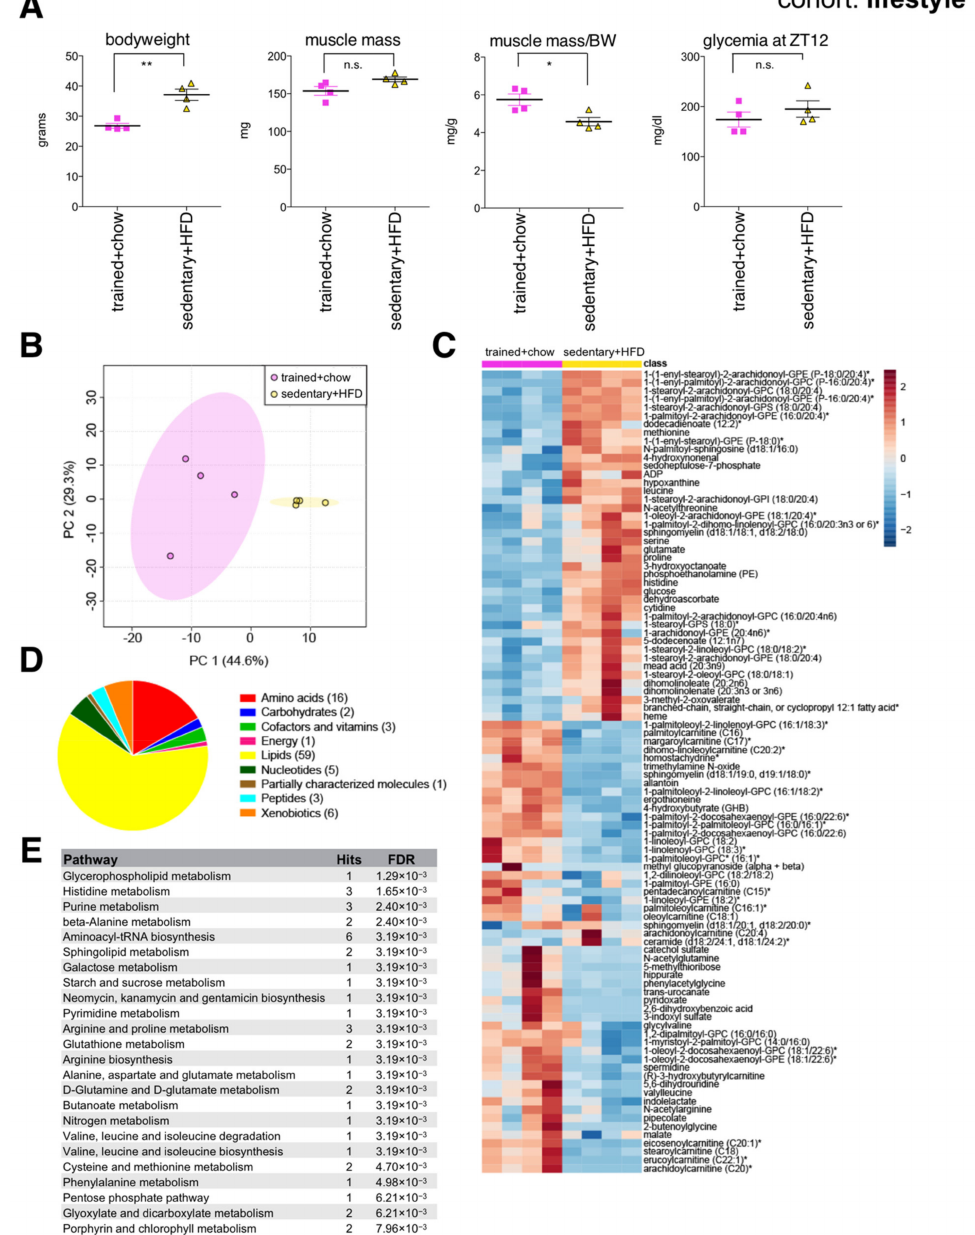
Figure 4. The skeletal muscle metabolome reflects changes associated with lifestyle. ( A ) Bodyweight, muscle weight ( gastrocnemius ), muscle weight relative to bodyweight (BW), and glycemia at zeitgeber time 12 (ZT12, 6 pm) of male C57BL/6J mice after five weeks of daily endurance training (1 h on a motorized treadmill) and eating a chow diet, or sedentary littermates after three months eating a high fat diet (HFD) (mean ± SEM; n = 4; ** p < 0.01, * p < 0.05, n.s. not significant, Student’s t -test). ( B ) Principal component analysis of the entire data set. ( C ) Heatmap of metabolites selected by random forest shown for individual samples. Metabolites labeled with an asterisk have not been confirmed with a standard, but we are confident of their identity. ( D ) Classification of random forest selected metabolites to their metabolite class. The number of metabolites per class is given in parentheses. ( E ) Quantitative enrichment analysis showing the top enriched pathways with FDR < 0.01 based on the metabolites selected by random